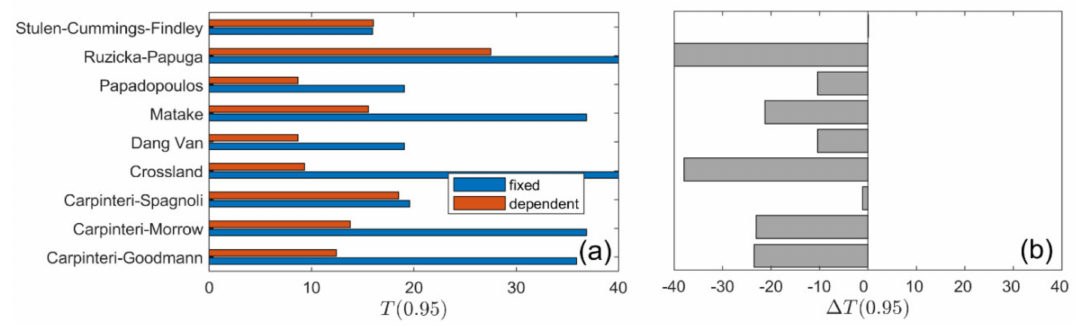
Figure 12. Summary comparison of calculation results for the analysed models under R = 0.0 for 7075-T651 aluminium alloy: ( a ) fatigue scatter band and ( b ) change in the fatigue scatter band for all analysed fatigue